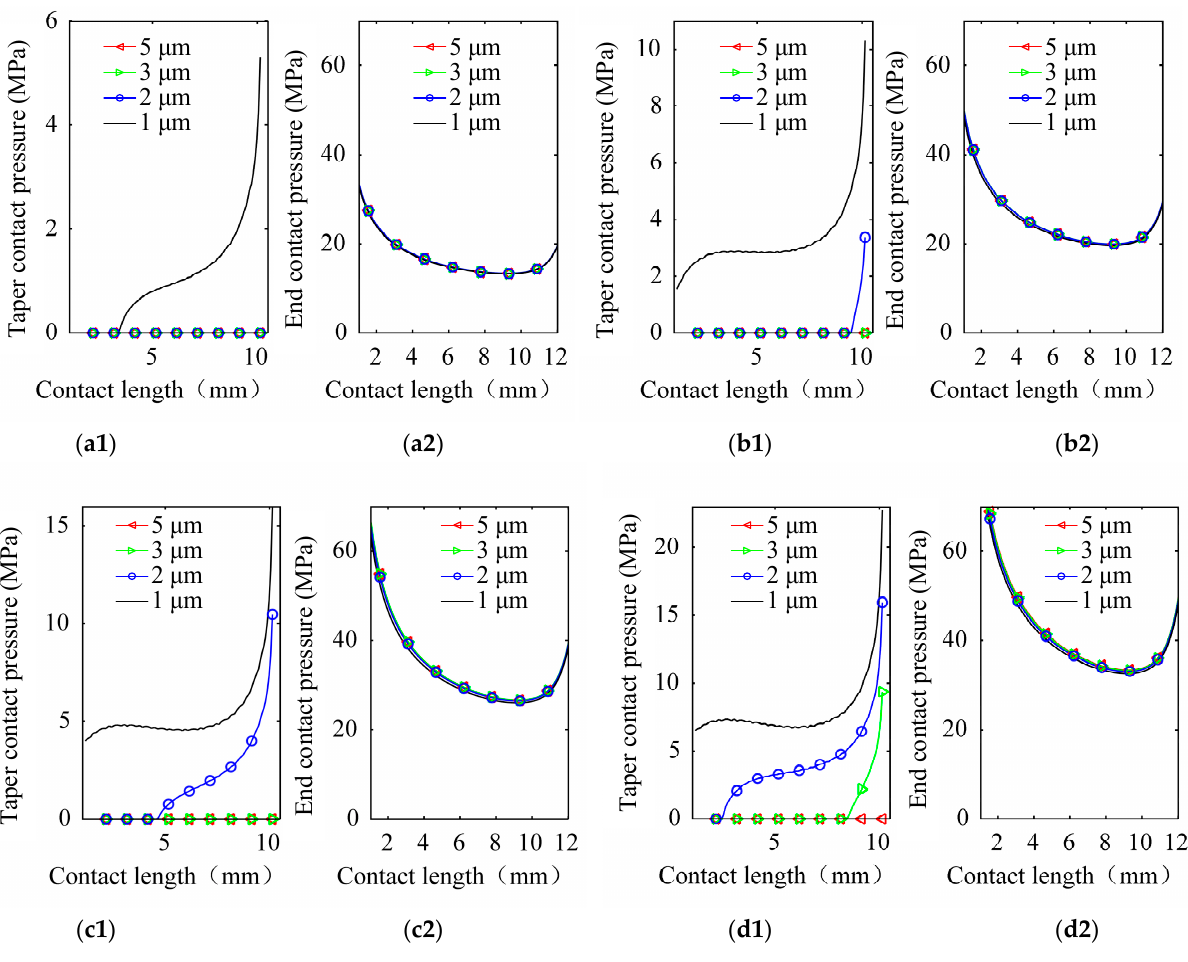
Figure 8. Effect of original taper clearance on contact pressure of the spindle–GWF interface under different tightening torques: ( a1 , a2 ) tapered contact pressure and end contact pressure of interface when tightening torque is 20 N·m; ( b1 , b2 ) tapered contact pressure and end contact pressure of interface when tightening torque is 30 N·m; ( c1 , c2 ) tapered contact pressure and end contact pressure of interface when tightening torque is 40 N·m; ( d1 , d2 ) tapered contact pressure and end contact pressure of interface when tightening torque is 50 N·m.